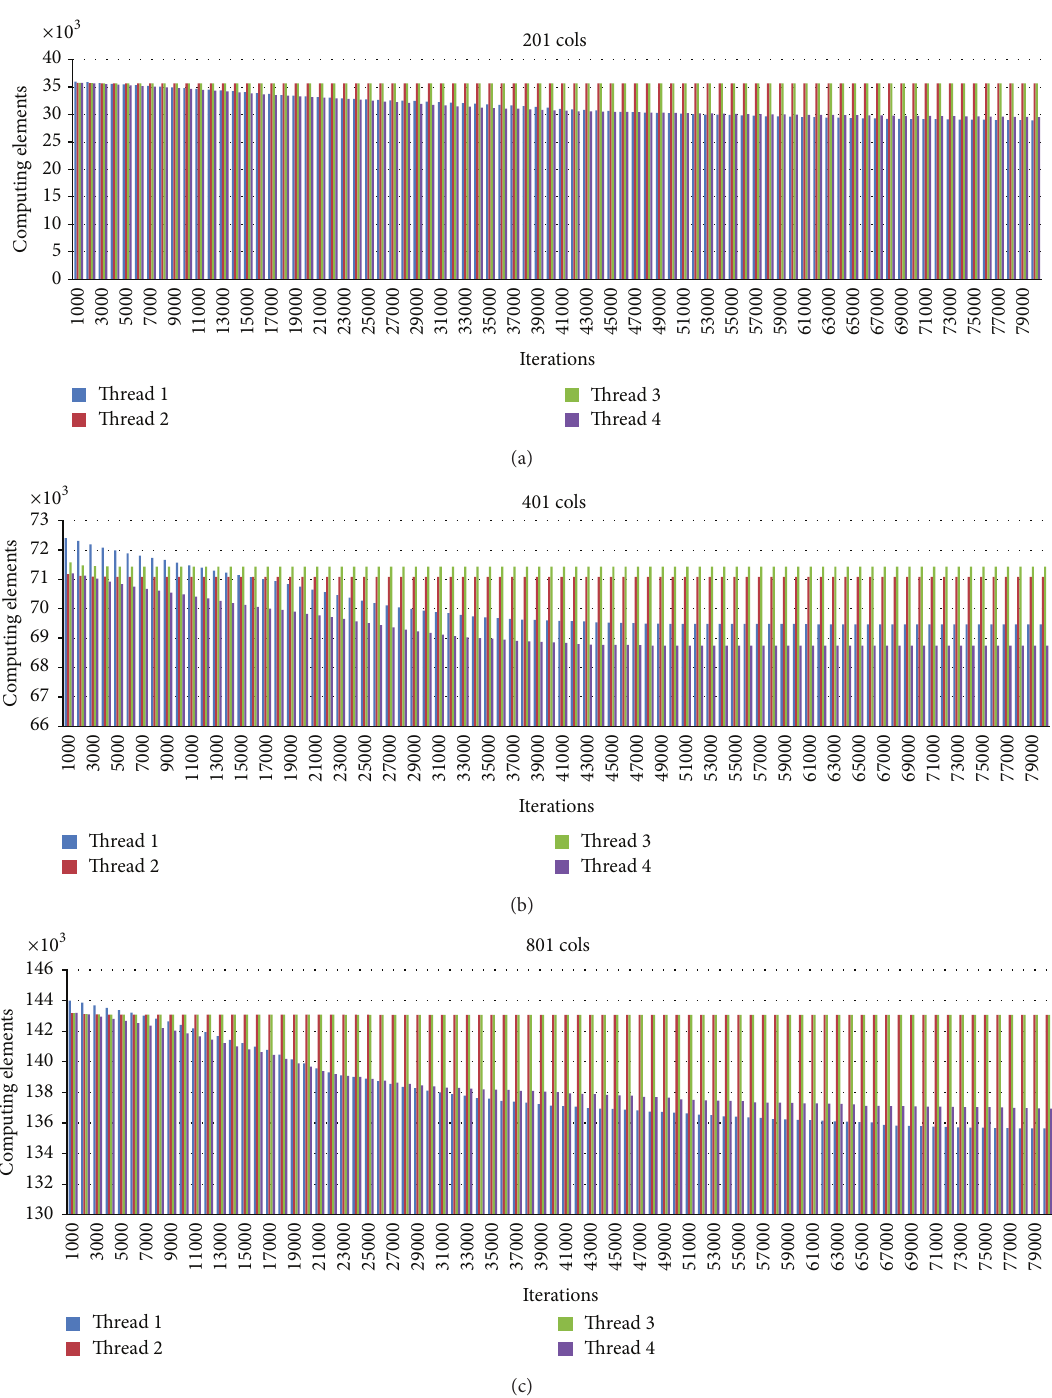
concentration. The varying schedule types are